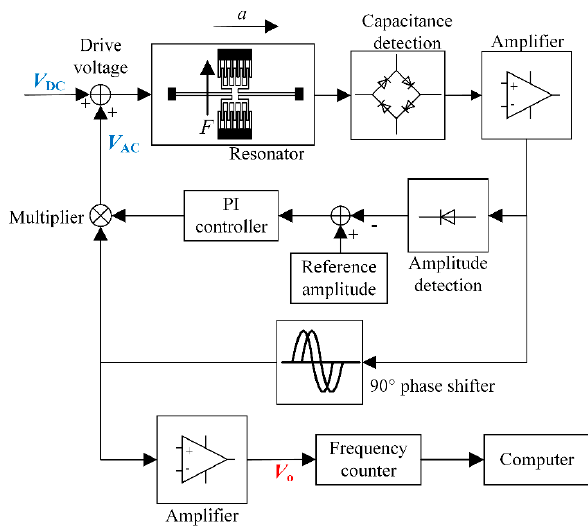
Figure 10. The block diagram of the MRA interface electronics. Table 1. Temperature drift of three types of MRA devices.